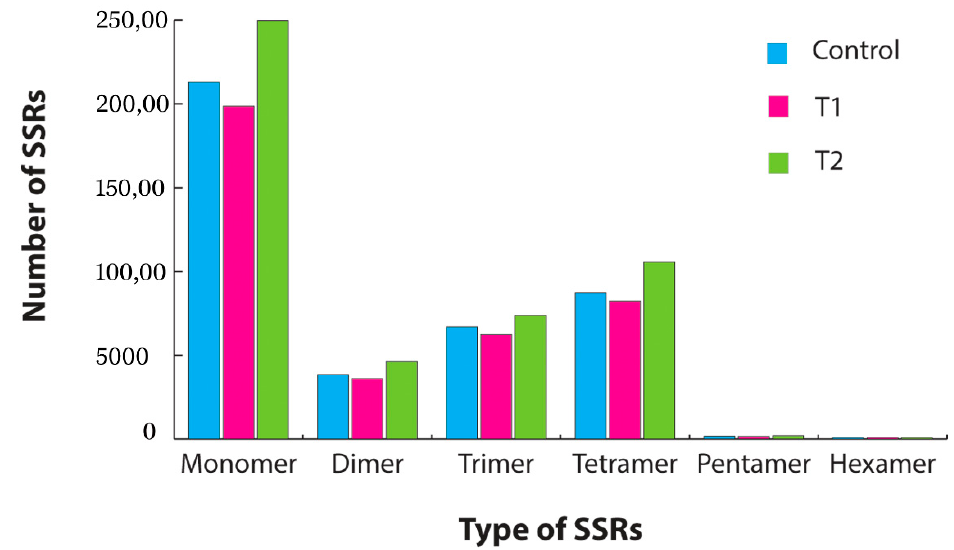
Figure 6. Simple sequence repeat (SSR) identification from the transcriptome data for each sample. Blue represents the identified SSR distribution in the control sample, pink represents the SSR distribution in the T1 (48 h PEG treatment) sample, and green represents the SSR distribution in the T2 (72 h PEG treatment) sample.